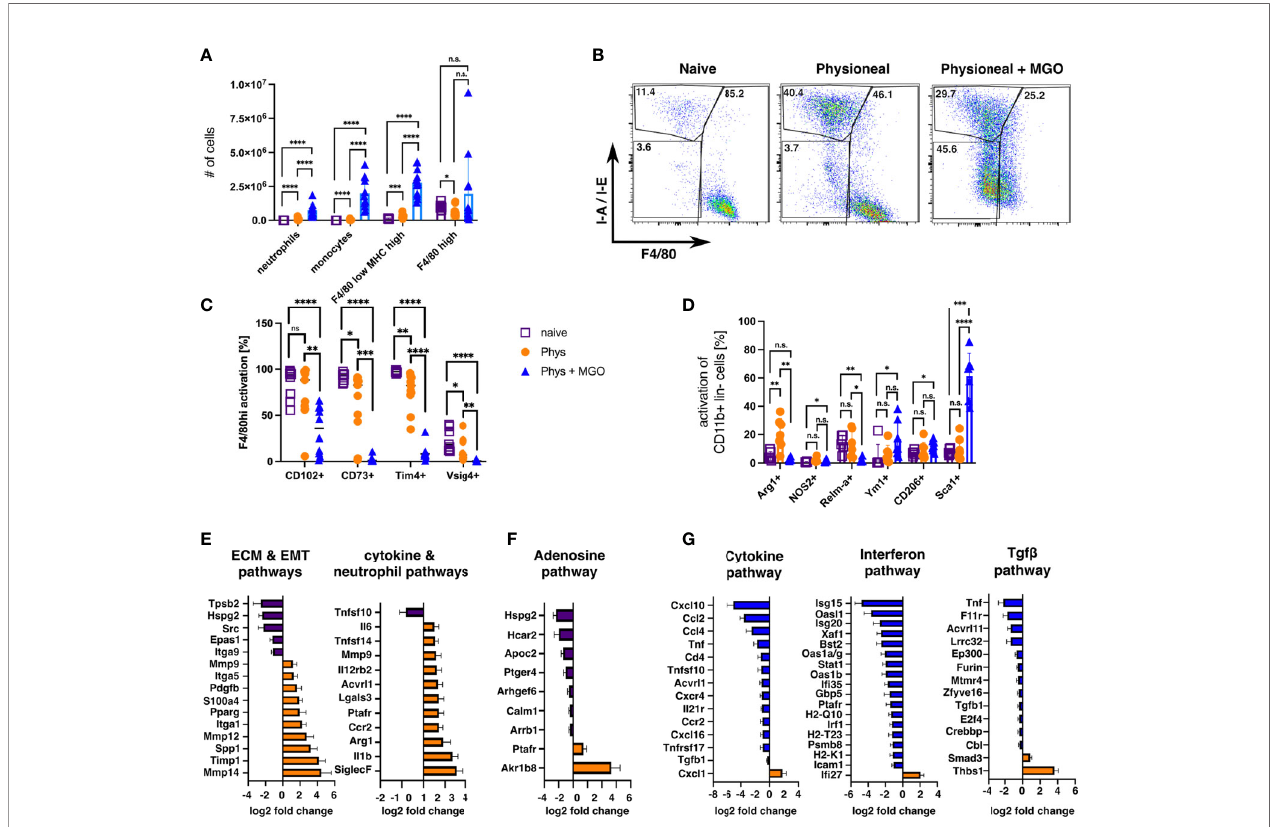
FIGURE 7 | Addition of glucose-degradation products strongly enhances peritoneal in fl ammation. C57BL/6 mice were injected with PD fl uid (Phys, circles) or PD fl uid supplemented with 40 mM Methylglyoxal (MGO, triangles) or were left untreated (naive, squares) 5 times a week for a total of 14 injections and analysed 24 h after the last injection. (A) Number of in fl ammatory cells isolated from the peritoneal cavity. (B) Sample dot plots depicting myeloid cells (CD11b+, lineage -) isolated from the animals in (A) . (C, D) Expression of M F res associated surface markers (C) as well as M F activation markers (D) . Datapoints depict individual animals and bars indicate mean and SD. Data from 3 independent experiments. Data analysed using 2-way ANOVA followed by Tukey ’ s post-hoc test after transformation. n.s., not signi fi cant; *p < 0.05; **p < 0.01; ***p < 0.001; ****p < 0.0001. (E – G) nCounter fi brosis panel analysis of whole PEC isolated in (A) . Bars indicate genes upregulated in naive (purple), Physioneal (orange) or Physioneal + Methylglyoxal (blue) treated animals. Data depicted as log2 fold change of signi fi cantly differentially expressed genes (p < 0.05) as mean and SEM of three animals per